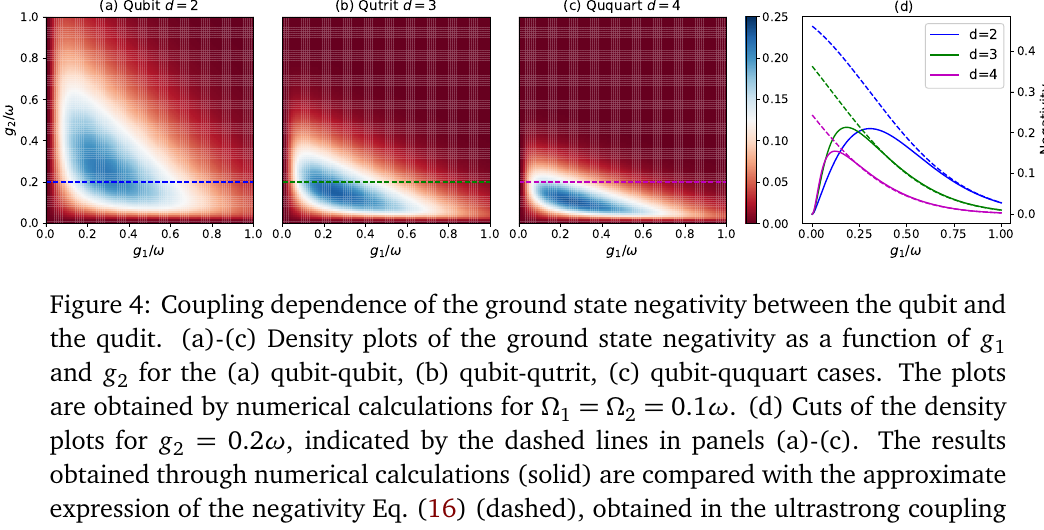
1 = Ω = 0.1 ω . (d) Cuts of the density 1 2